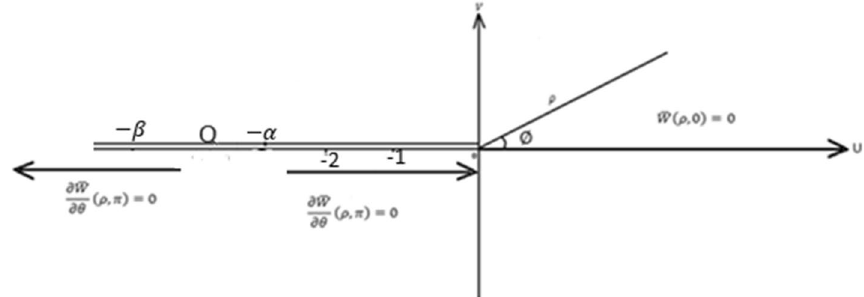
Fig. 2 Transformed configuration of the original